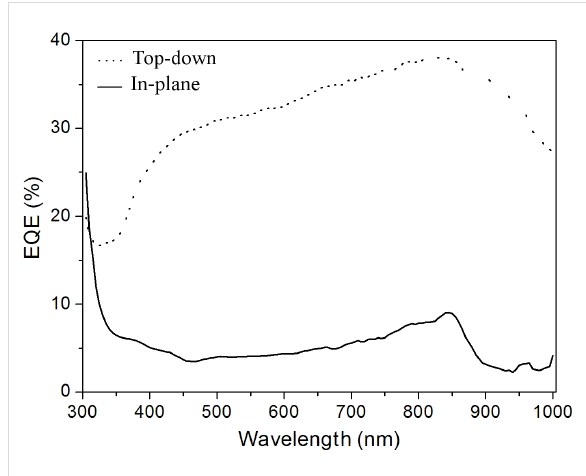
Figure 9: External quantum efficiency (EQE) spectra obtained in the top-down (dotted curve) and in-plane (filled curve) geometries of the device. The maximum value achieved in the case of the top-down con- figuration is 37% (at 850 nm), while in the planar one it is 10% (at 850 nm). The two line shapes are very different: in the top-down setup the EQE curve is very similar to that of a commercial p–n silicon solar cell, with a low absorption at ultraviolet wavelengths, whereas in the in-plane case, there is a rise that is characteristic of MWCNT